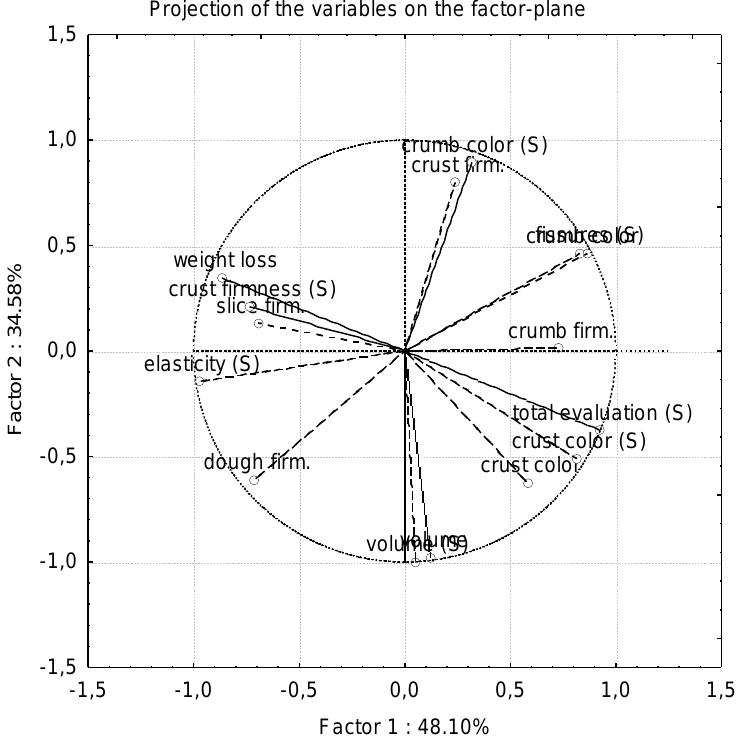
Figure 4. Principal Component Analysis (PCA) variables plot (firm. refers to firmness).